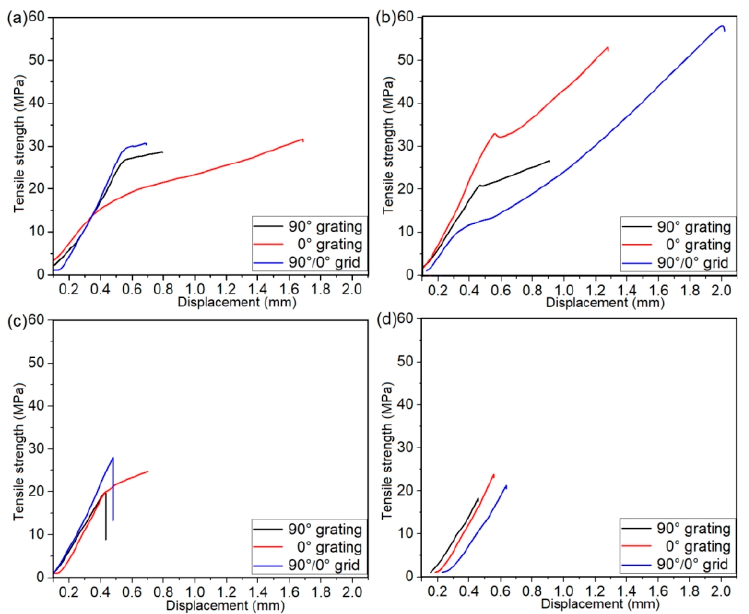
Figure 6. Tensile strength versus strain displacement curves of the CCF30/PEEK-Ti6Al4V joints with microgroove widths of 225 ± 15 μ m ( a ), 265 ± 10 μ m ( b ), 335 ± 10 μ m ( c ), and 425 ± 15 μ m ( d ), respectively.